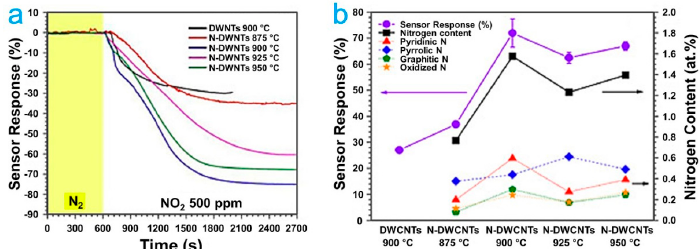
Figure 7. ( a ) sensor responses (%) of all sensors toward 500 ppm of NO 2 as a function of time. ( b ) sensor response saturation limit (left axis) and the ratio of different types of nitrogen as a function of synthesized temperature [39].